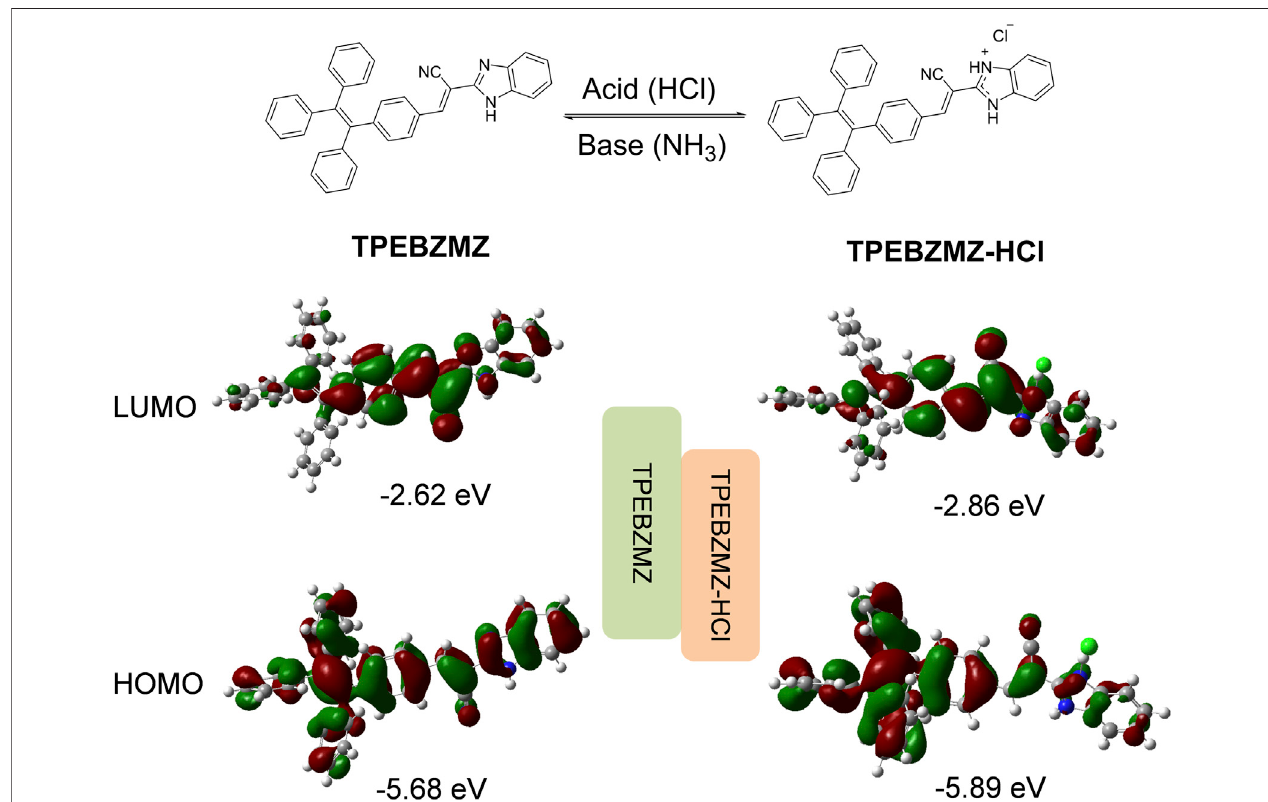
FIGURE 5 | Proposed reaction mechanism for TPEBZMZ treated with HCl and NH 3 , and the frontier molecular orbital distributions of TPEBZMZ and HCl-fumed TPEBZMZ (TPEBZMZ-HCl) determined using DFT by Gaussian 09 at the B3LYP/6-311G(d,p) level.